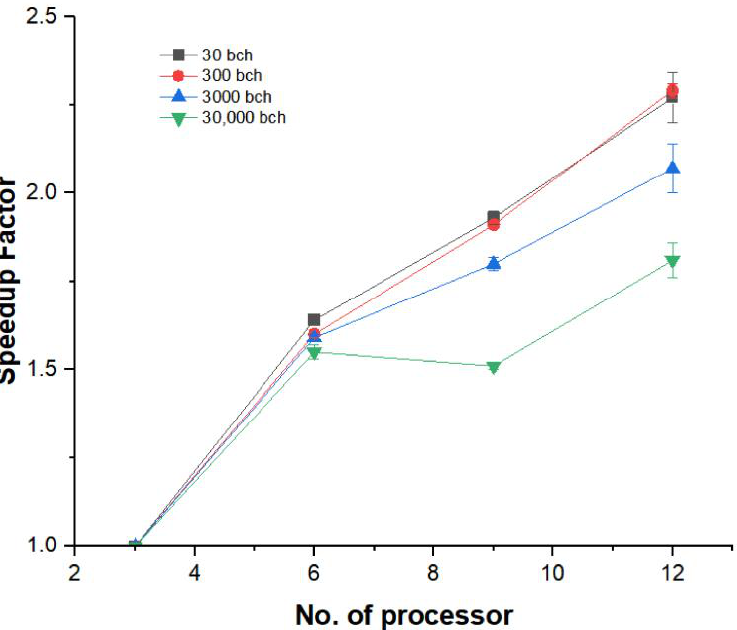
Figure 8. Speedup factor increase trend according to bch change: the average value of five average CPU times required to perform 3 × 10 8 iterations of the computational simulation for the PDD in the 10 cm × 10 cm field size was analyzed. Table 8. K-factor. Because it is a part where parallel processing such as data communication and collection is impossible in the configured cluster, it has been calculated using the least squares Table 7. Speedup factor. Based on three processors, as the number of processors increased to 6, 9, and 12, the comparison was made. In order to exclude the effect of the difference in performance between nodes, the entire processor was evaluated by adding one from each node. The results of five iterations were averaged. Avg means the average value at this time, and SD means the stand- ard deviation of the measured values.